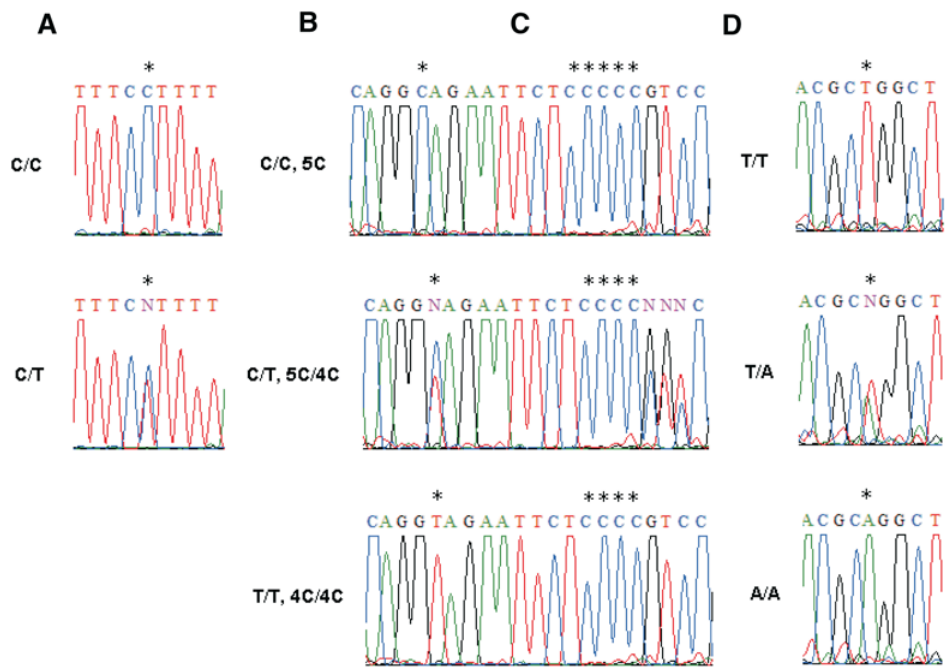
Figure S1 - Promoter polymorphisms of p16 INK4a at positions -1602, -871, -862 to -858, and -315. (A-D) Genomic DNA was amplified by PCR with for- ward primers at positions -2028 to -2009, -1198 to -1174, and -485 to -465 and reverse primers at -1173 to -1192, -475 to -498, and +214 to +194 of the p16 INK4a gene; nucleotide sequences were determined by directly sequencing the PCR products. These sequencing reactions were performed using prim- ersatpositions-1706to-1684,-950to-931,and-381to-361.(*)showsnucleotidesatpositions-1602(A),-871(B),-862to-858(C),and-315(D)inthe p16 INK4a promoters, where “N” indicates heterozygous nucleotides. “NNNC” in (C) indicates sequences including “CGTC” and “GTCC,” which result from nucleotide C deletion. Nucleotides around these positions (*) are